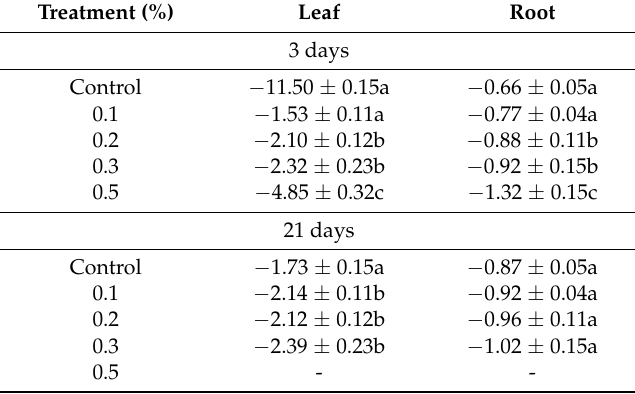
Table 5. Effect of soil salinity on the osmotic potentials (MPa) of leaves and roots of mulberry plants grown for 3 and 21 days under greenhouse conditions. Data in each column with the same letter are not significantly different ( P =